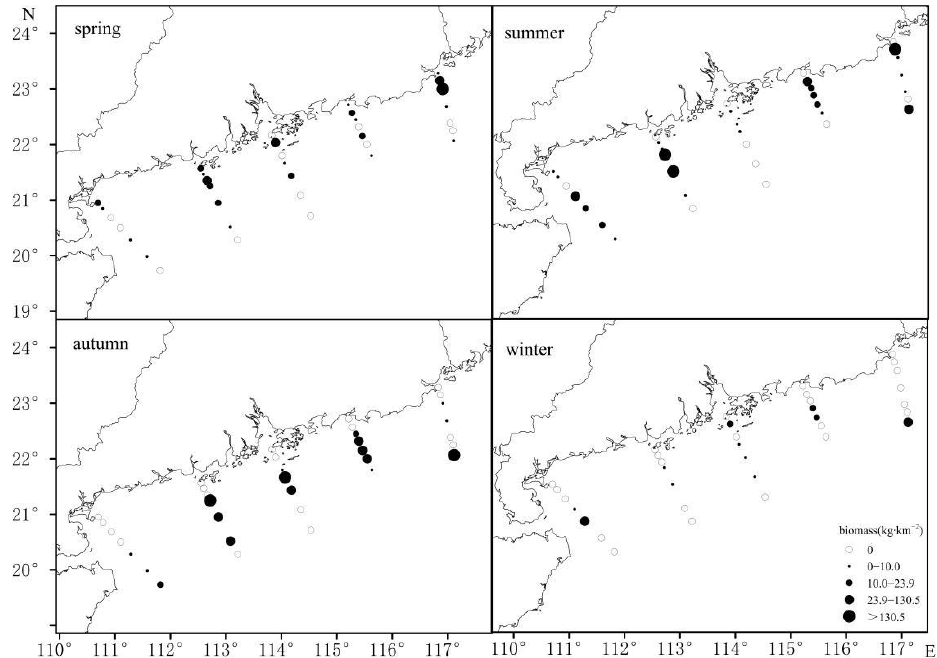
Figure 2. Temporal and spatial distribution of Evynnis cardinalis biomass in the northern South China sea.